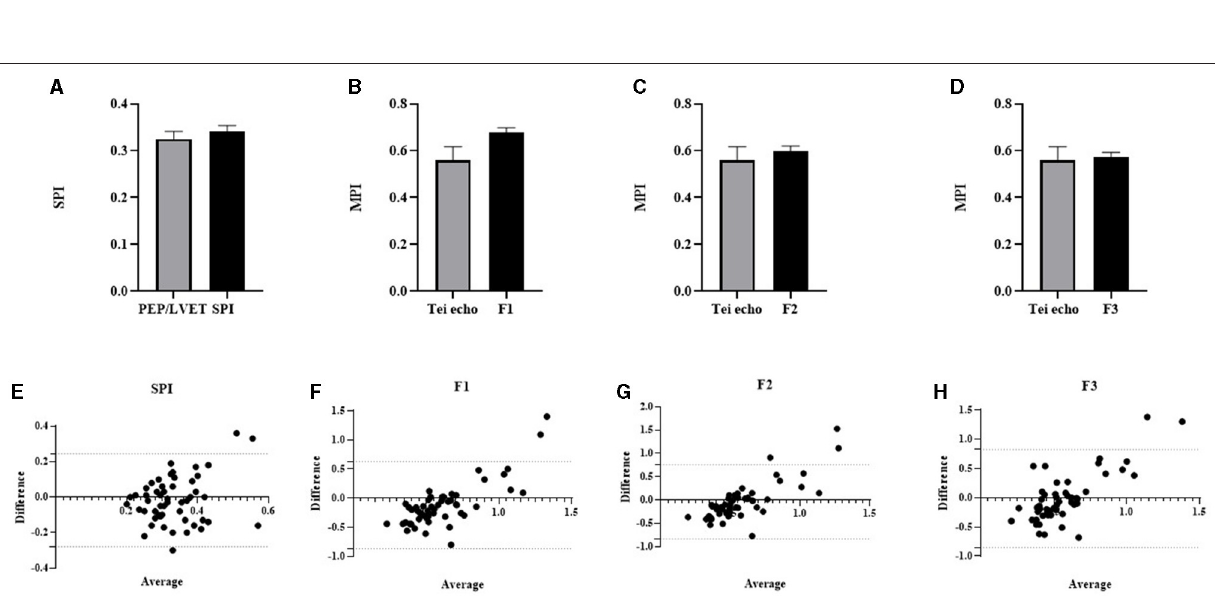
Frontiers in Veterinary Science |